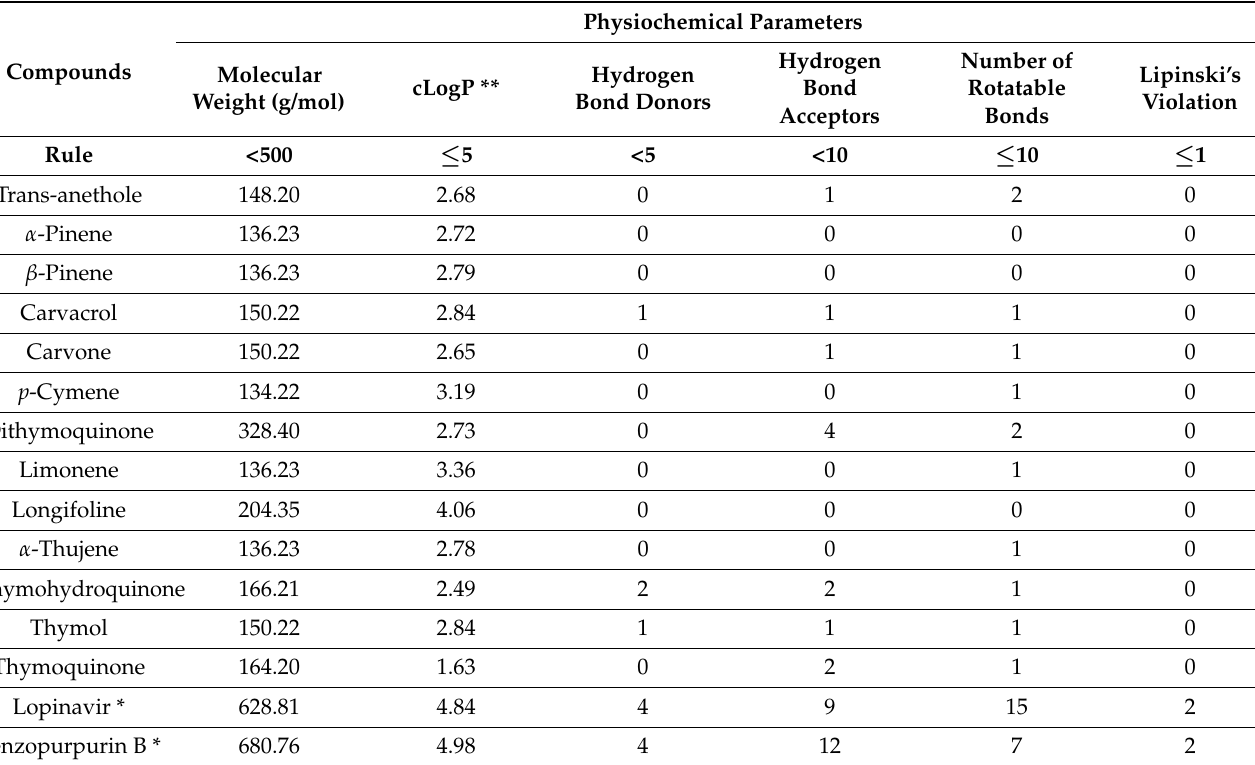
Table 2. Among the control drugs, both lopinavir and benzopurpurin violated the Lipinski rule with a molecular weight of approximately 628.81 g/mol and 680.76 g/mol higher than 500 g/mol, respectively. Lopinavir and benzopurpurin also have a higher number of rotat- able bonds and hydrogen bond receptors. Our molecule of interest, DTQ, has a molecular weight of 328.40 g/mol, which is suitable for crossing the biosystem’s membrane barriers. It also has a cLogP value of approximately 2.73, indicating the compound’s moderately lipophilic nature with proper absorption in the gastro-intestinal tract with no violation of the Lipinski rule. Thus, it makes a promising candidate for combating COVID-19. Table 2. Physicochemical properties of ‘active components of Nigella sativa ’ and ‘control compounds’.